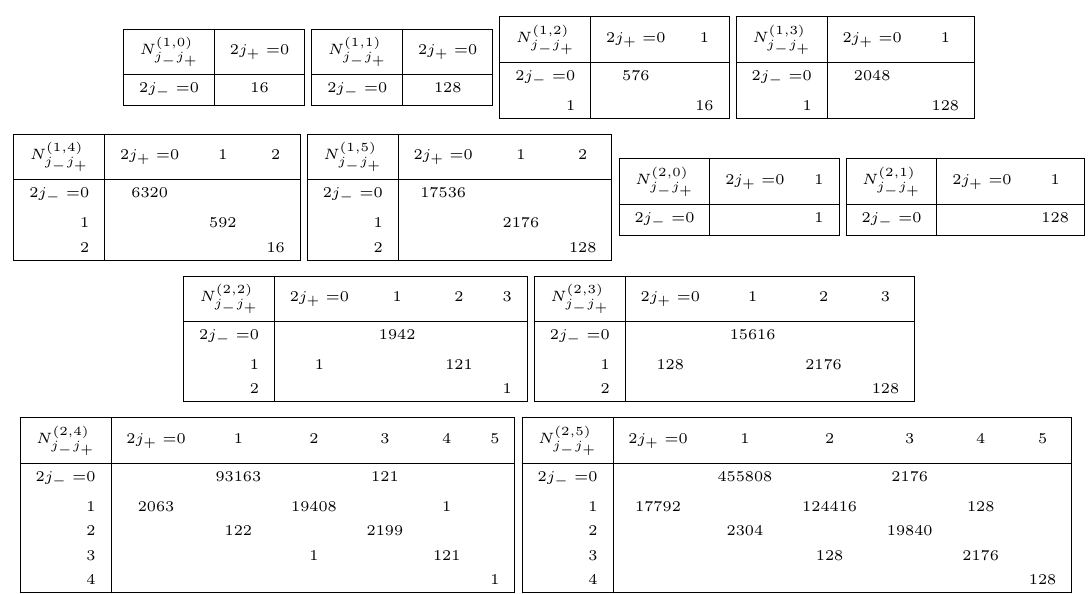
Table 9 . Re(cid:12)ned BPS invariants N ( b;d )